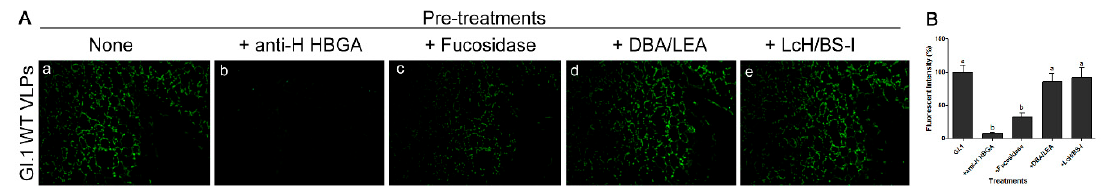
Figure 5. ( A ) Immunofluorescence assay showing the binding of (a) GI.1 VLPs to the lettuce tissues without any pre-treatment and following pre-treatments with (b) anti-H HBGA antibody, (c) fucosidase enzyme or lectins (d) DBA/LEA and (e) LcH/BS-1, Magnification: 40× . ( B ) Quantification of fluorescent intensity. Means with different letters differ significantly.